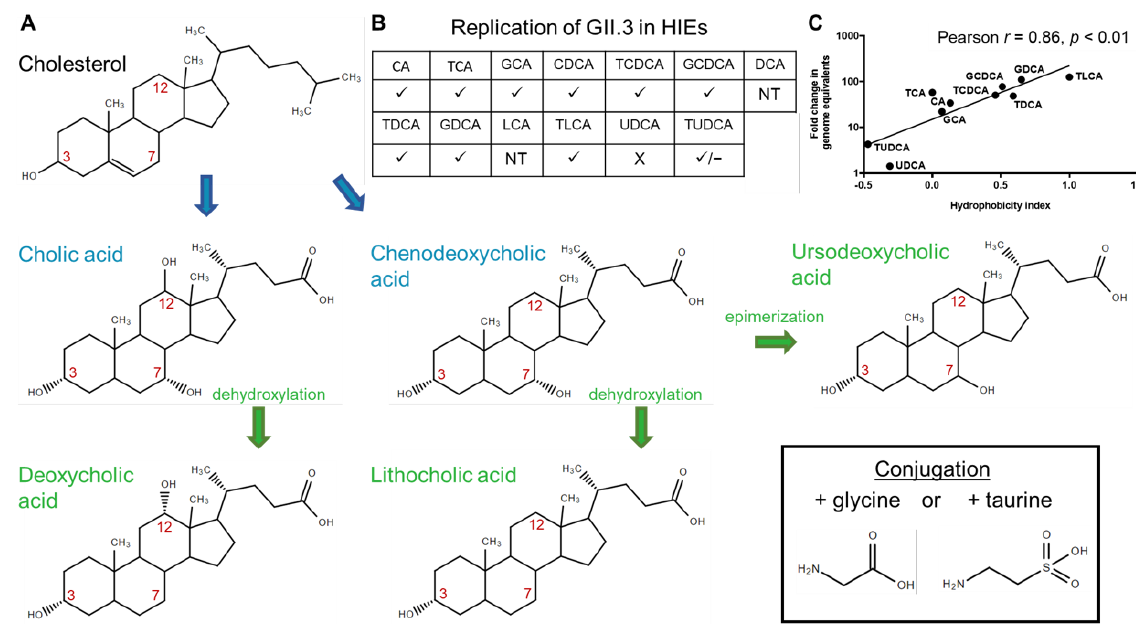
Table 1. Bile acid receptors.